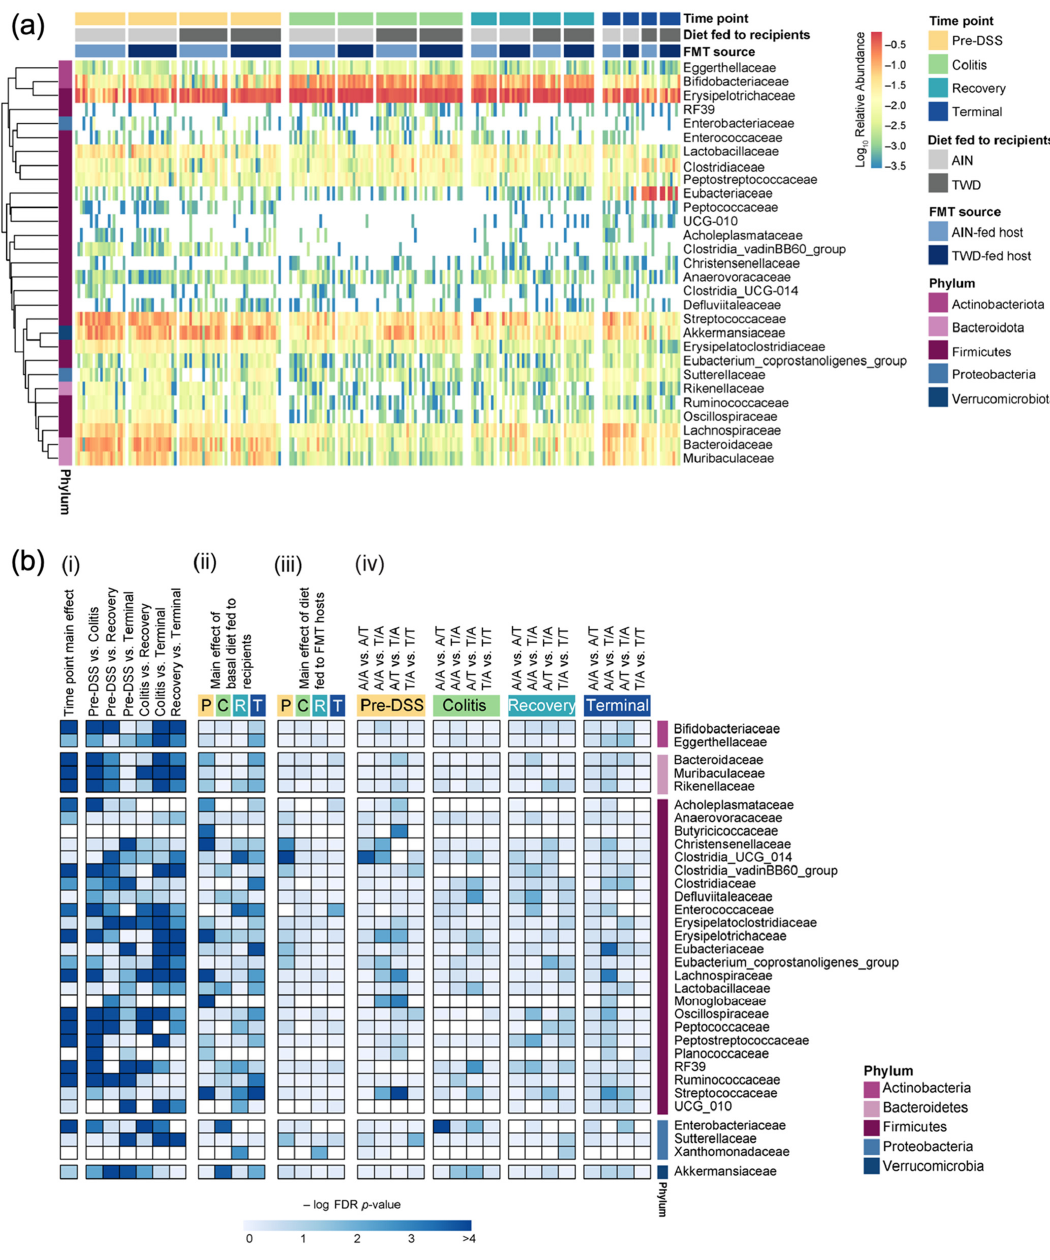
Figure 5. Relative abundance of fecal microbiome at the family taxonomic level with a summary of the results from the metagenomeSeq statistical analyses. ( a ) Unsupervised hierarchical cluster analysis shows the log 10 relative abundance with clustering by taxa using the Euclidean distance with average linkage ( n = 19 to 20 cages per group at the pre-DSS time point, n = 17 to 18 cages per group at the active colitis time point, n = 12 to 13 cages per group at the recovery time point, and n = 7 to 8 cages per group at the terminal time point). ( b ) Summary plot shows the log 10 FDR-adjusted p -values obtained from the metagenomeSeq analyses of fecal microbiome profiles. All tests were determined a priori, and the complete results are provided in Supplementary File S2. (i) Analyses for the main effects of time point and pairwise comparisons across time points, irrespective of basal diet or FMT source. (ii) Analyses for diet main effects, irrespective of FMT source, at each time point. (iii) Analyses for FMT source main effects, irrespective of basal diet, at each time point. (iv) Selected pairwise tests for basal diet and FMT source combinations within each study time point. The abbreviations for the recipient basal diet/FMT source are as follows: A/A, fed AIN/fmt AIN; A/T, fed AIN/fmt TWD; T/A, fed TWD/fmt AIN; and T/T, fed TWD/fmt TWD. A significant effect is inferred for FDR-adjusted p -values < 0.05 (increasing blue on the color scale).